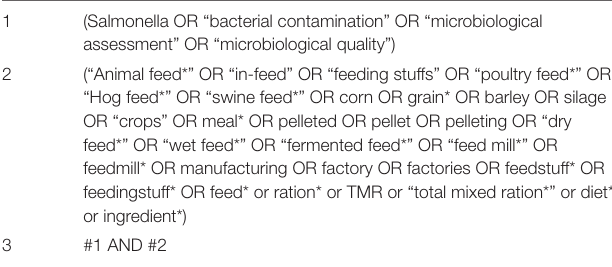
TABLE 1 | Search string to identify literature related to Salmonella in animal feeds in Medline® (via PubMed) on Oct. 23,